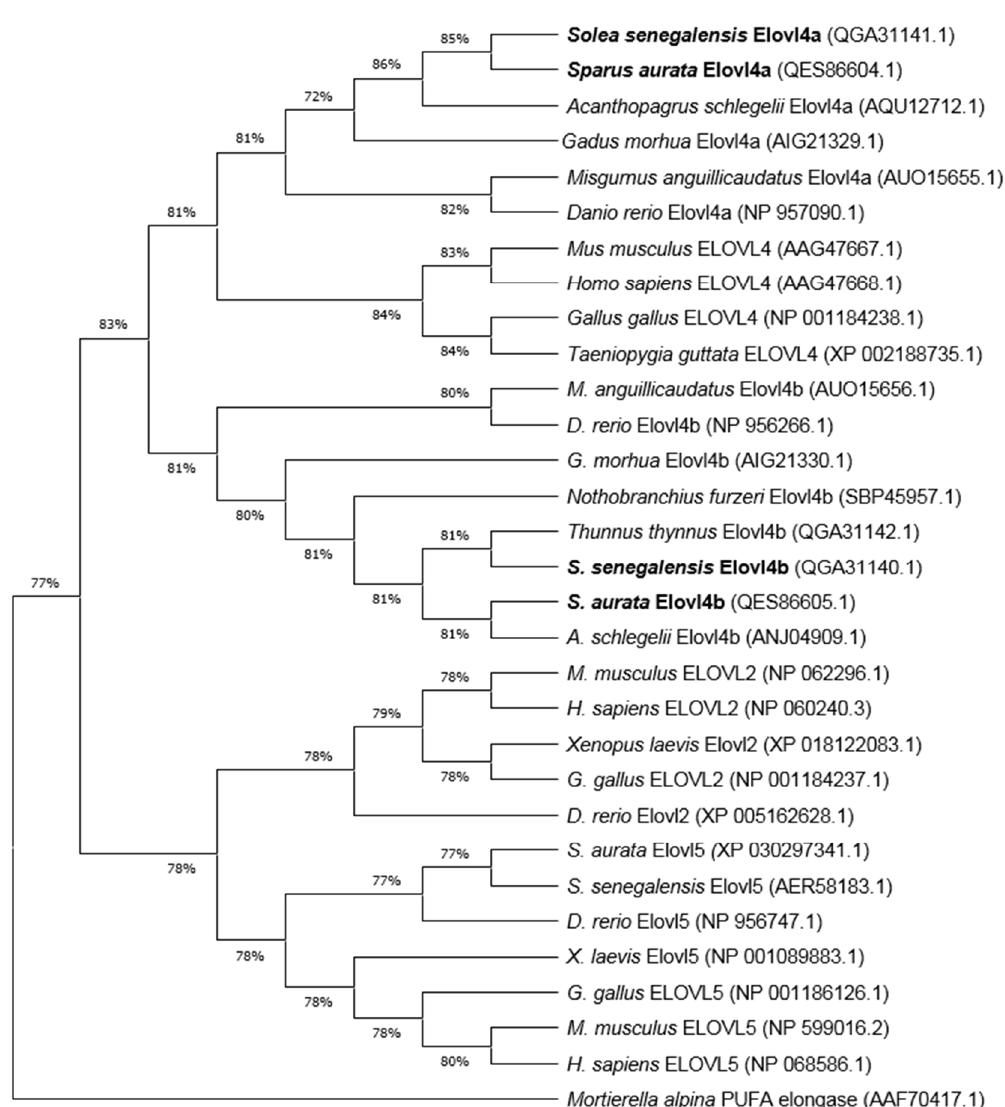
Figure 2. Phylogenetic tree comparing Sparus aurata and Solea senegalensis Elovl4a and Elovl4b proteins (highlighted in bold) with Elovl2, Elovl4 and Elovl5 proteins from other vertebrates. The tree was constructed while using the Maximum Likelihood method and Jones-Taylor-Thornton (JTT) matrix-based model. The numbers in branches represent the frequencies (%) of each node after 1000 iterations by bootstrapping. The Mortierella alpina PUFA elongase was included in the analysis as an outgroup, to construct the rooted tree.